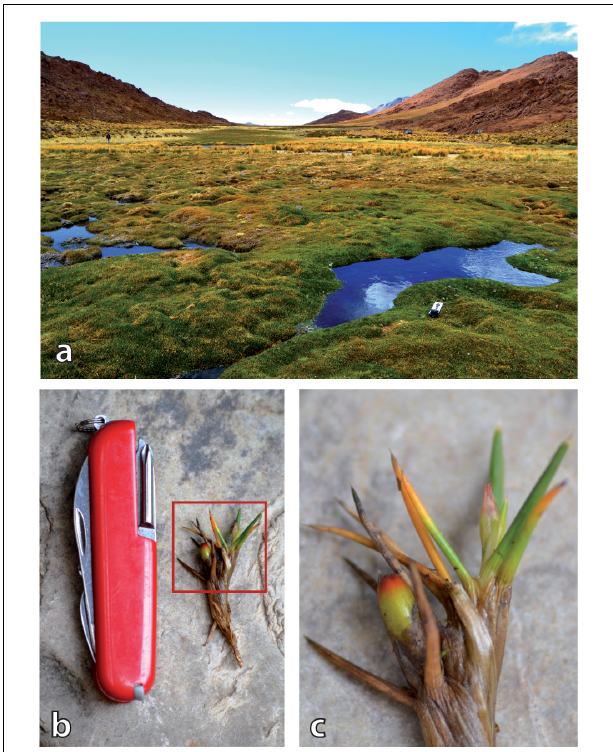
FIGURE 2 | (a) Picture of the CTP (in NNW direction) showing several cushions formed by Oxychloe andina , interspersed by shallow pools that are connected through superficial rivulets (November 2014). (b) O. andina plant compared to a pocketknife (November 2014). (c) Enlargement of the top part of the O. andina shoot. Inner part is composed of young leafs (green) and the flower (pink top). The fruit (greenish-yellow bottom and red top) is located close to the rhizomes (November